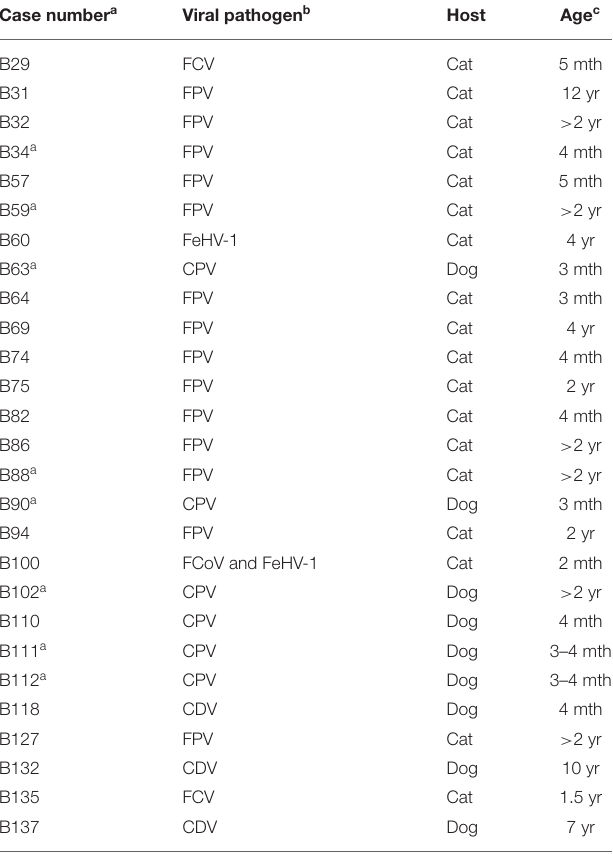
TABLE 1 | Positive cases from molecular